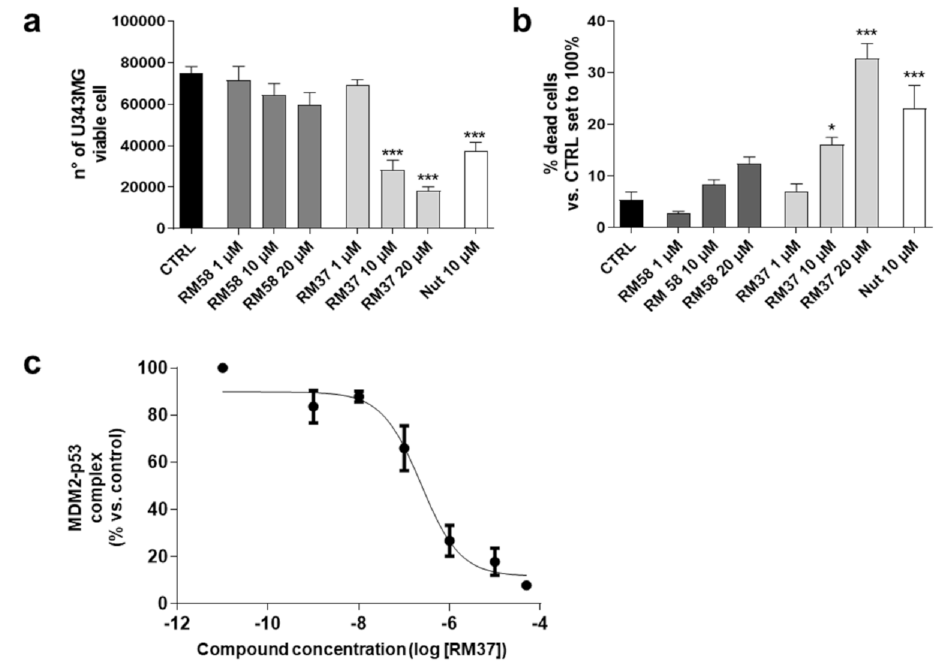
Figure 4. Effects of RM37 and RM58 on U343MG glioblastoma cells. U343MG cells were treated with different concentrations of RM37 and RM58 for 48h. The number of viable cells ( a ) and percentage of dead cells ( b ) were reported. Significance of the differences was determined with a one-way ANOVA with Bonferroni post-test * p < 0.05; *** p < 0.001 versus CTRL. ( c ) RM37 was incubated with GBM cell lysates containing the native MDM2–p53 complex, and levels of MDM2–p53 complex were quantified using HRP-conjugated antibody and TMB substrate. Data represent mean ± SEM of three independent